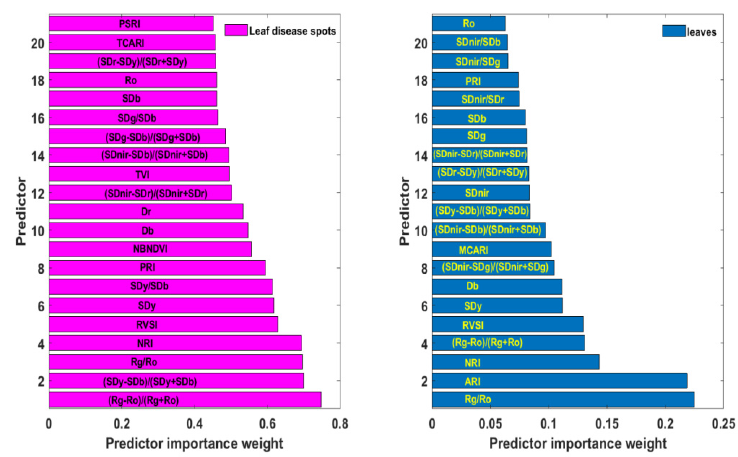
Figure 5. The importance order of spectral variables with the top 50% weight at leaf lesion and leaf scale.